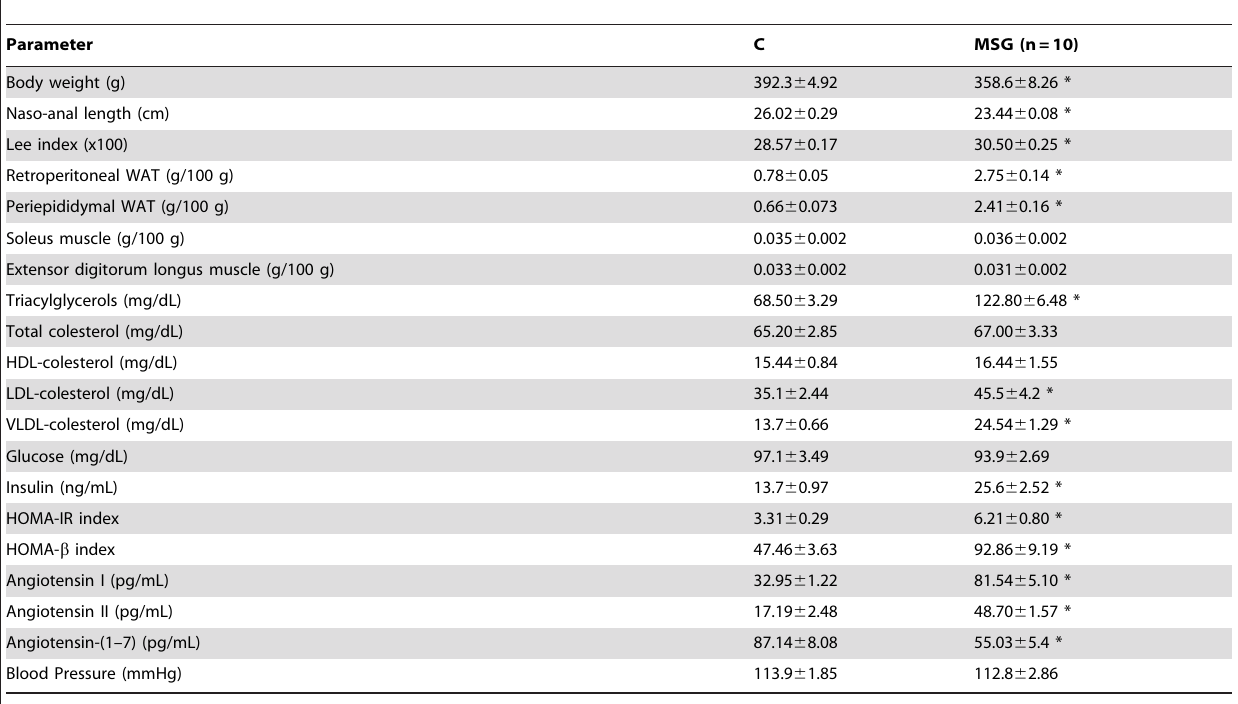
Table 1. General characteristics of sixteen-week-old control and obese rats.